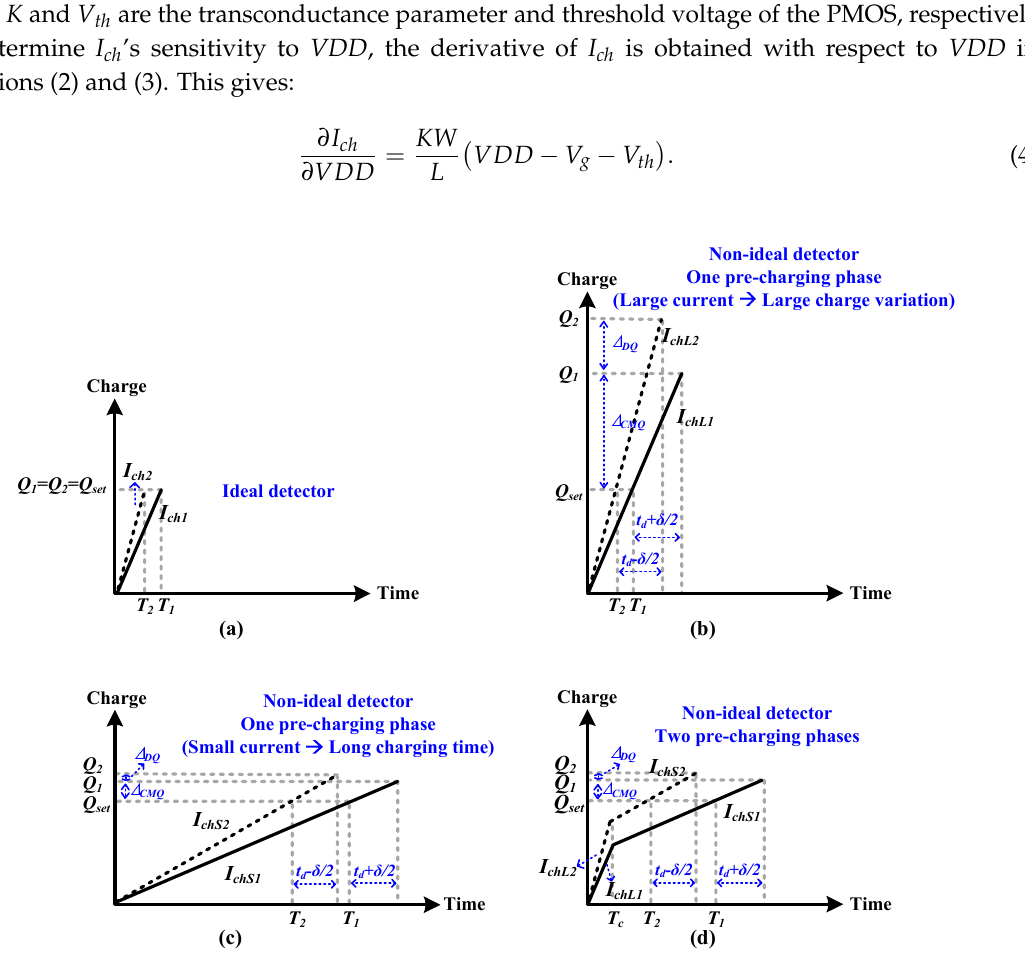
Figure 3. Self-timed pre-charging ( a ) ideal detector; ( b ) non-ideal detector using one pre-charging phase with large current; ( c ) non-ideal detector using one pre-charging phase with small current; and ( d ) non-ideal detector using two pre-charging phases.